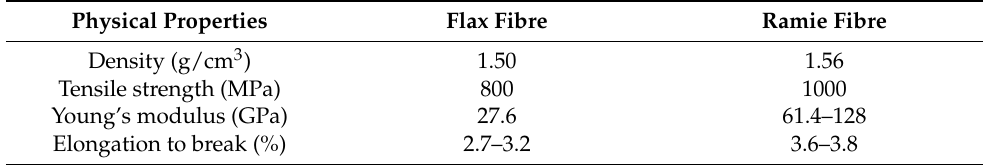
Table 1. Physical properties of the reinforcement materials.